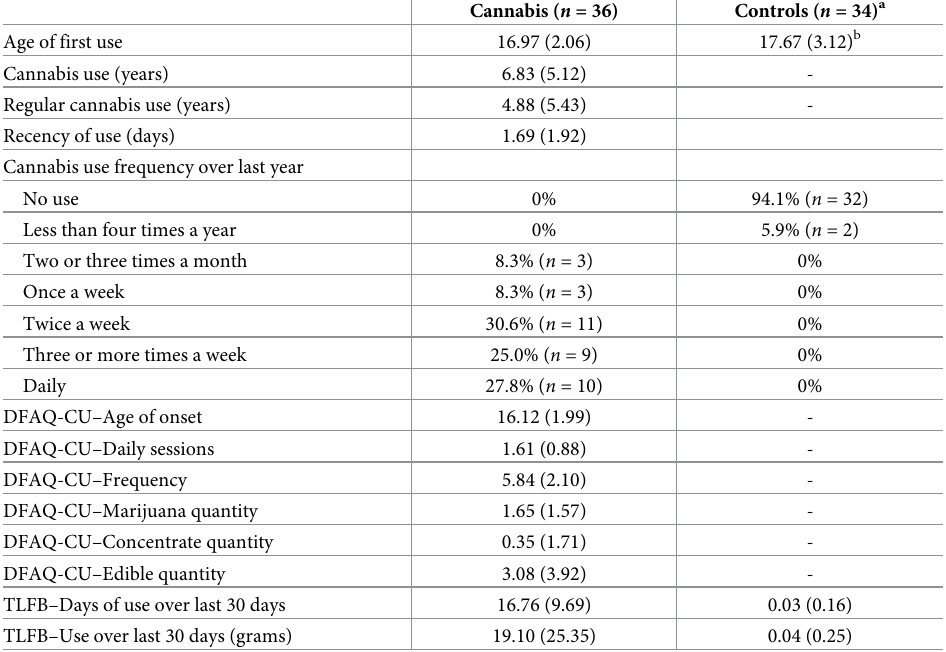
Table 2. Cannabis use